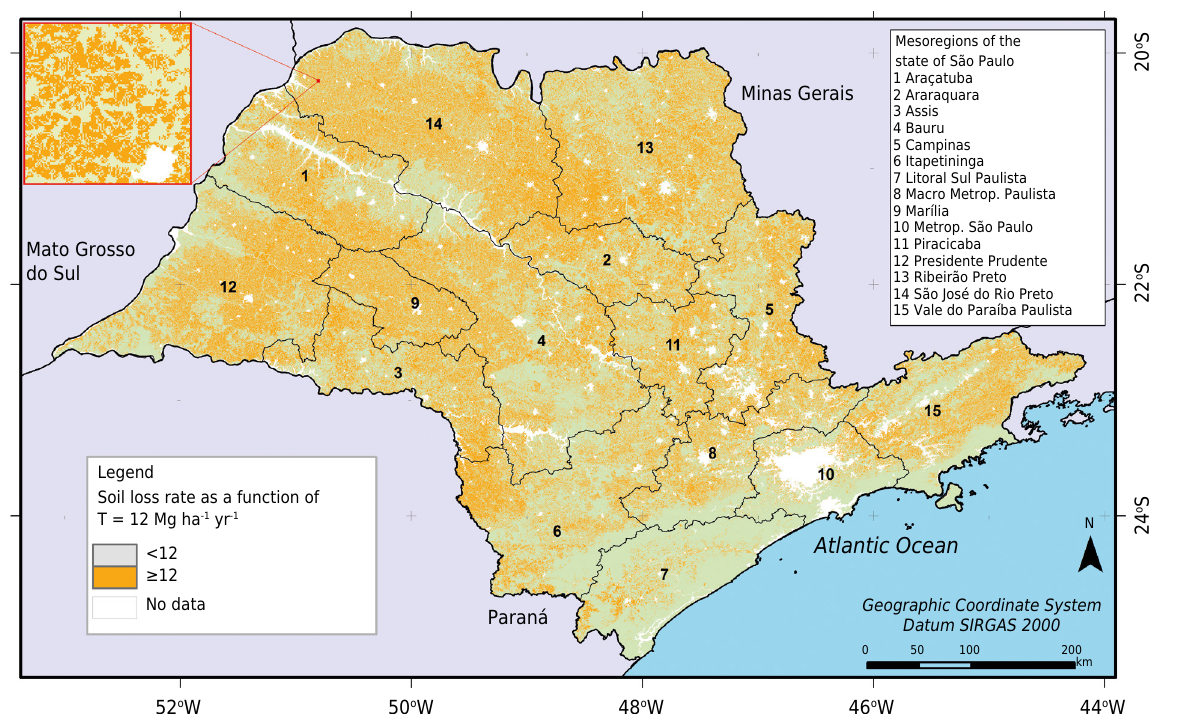
Figure 11. Map of soil conservation/degradation of the state of São Paulo based on average rate of tolerance to soil loss of 12 Mg ha -1 yr -1